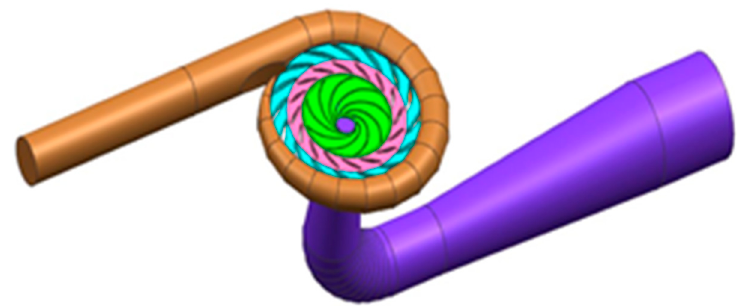
Figure 3. Whole flow passage model.